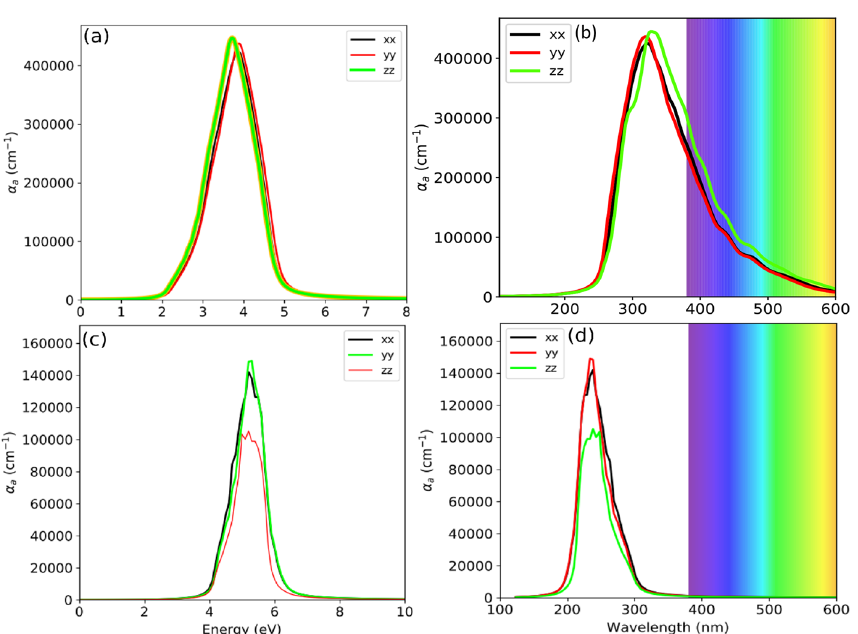
Figure 8. Absorption coefficient ( α a ) of bulk with respect to ( a ) Photon energy (eV) ( b ) Wavelength (nm), and Absorption coefficient ( α a ) of 001-surface with respect to ( c ) Photon energy (eV) ( d ) Wavelength